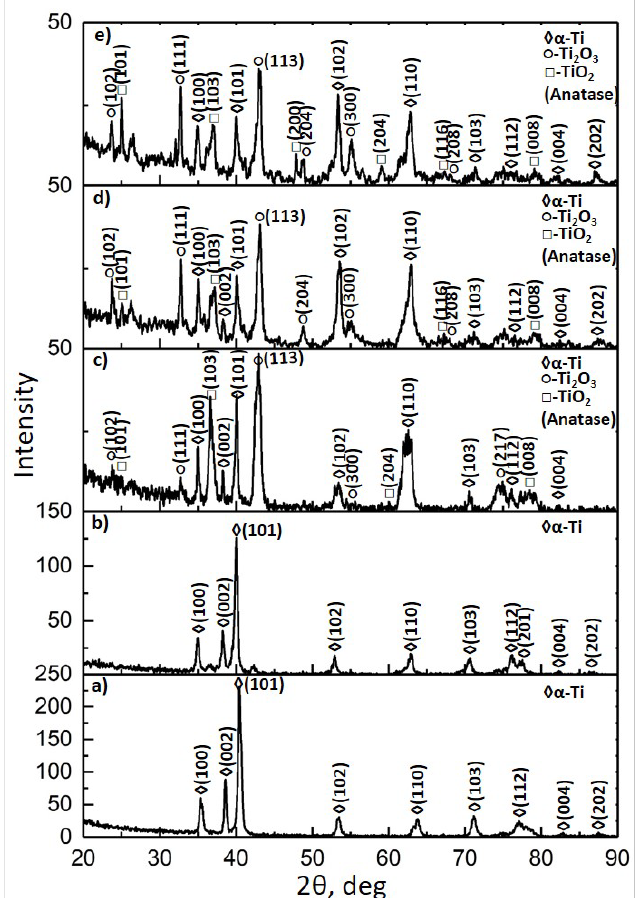
Figure 2. X-ray diffractograms of powder ( a ) and detonation coatings: Ti1 ( b ), Ti2 ( c ), Ti3 ( d ), and gradient ( e ).